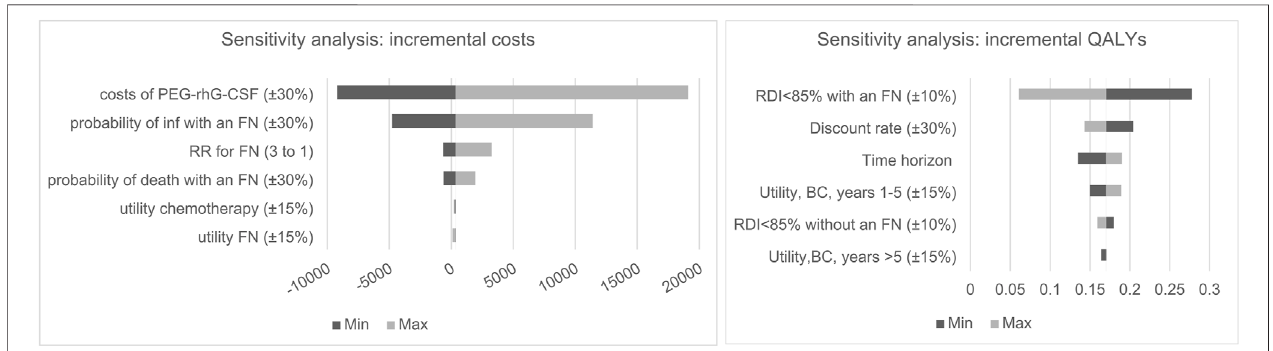
FIGURE 2 | One-way sensitivity analysis tornado diagram for incremental cost and QALY, BC, Breast cancer, inf, infection; FN, ferbrile eutropenia.